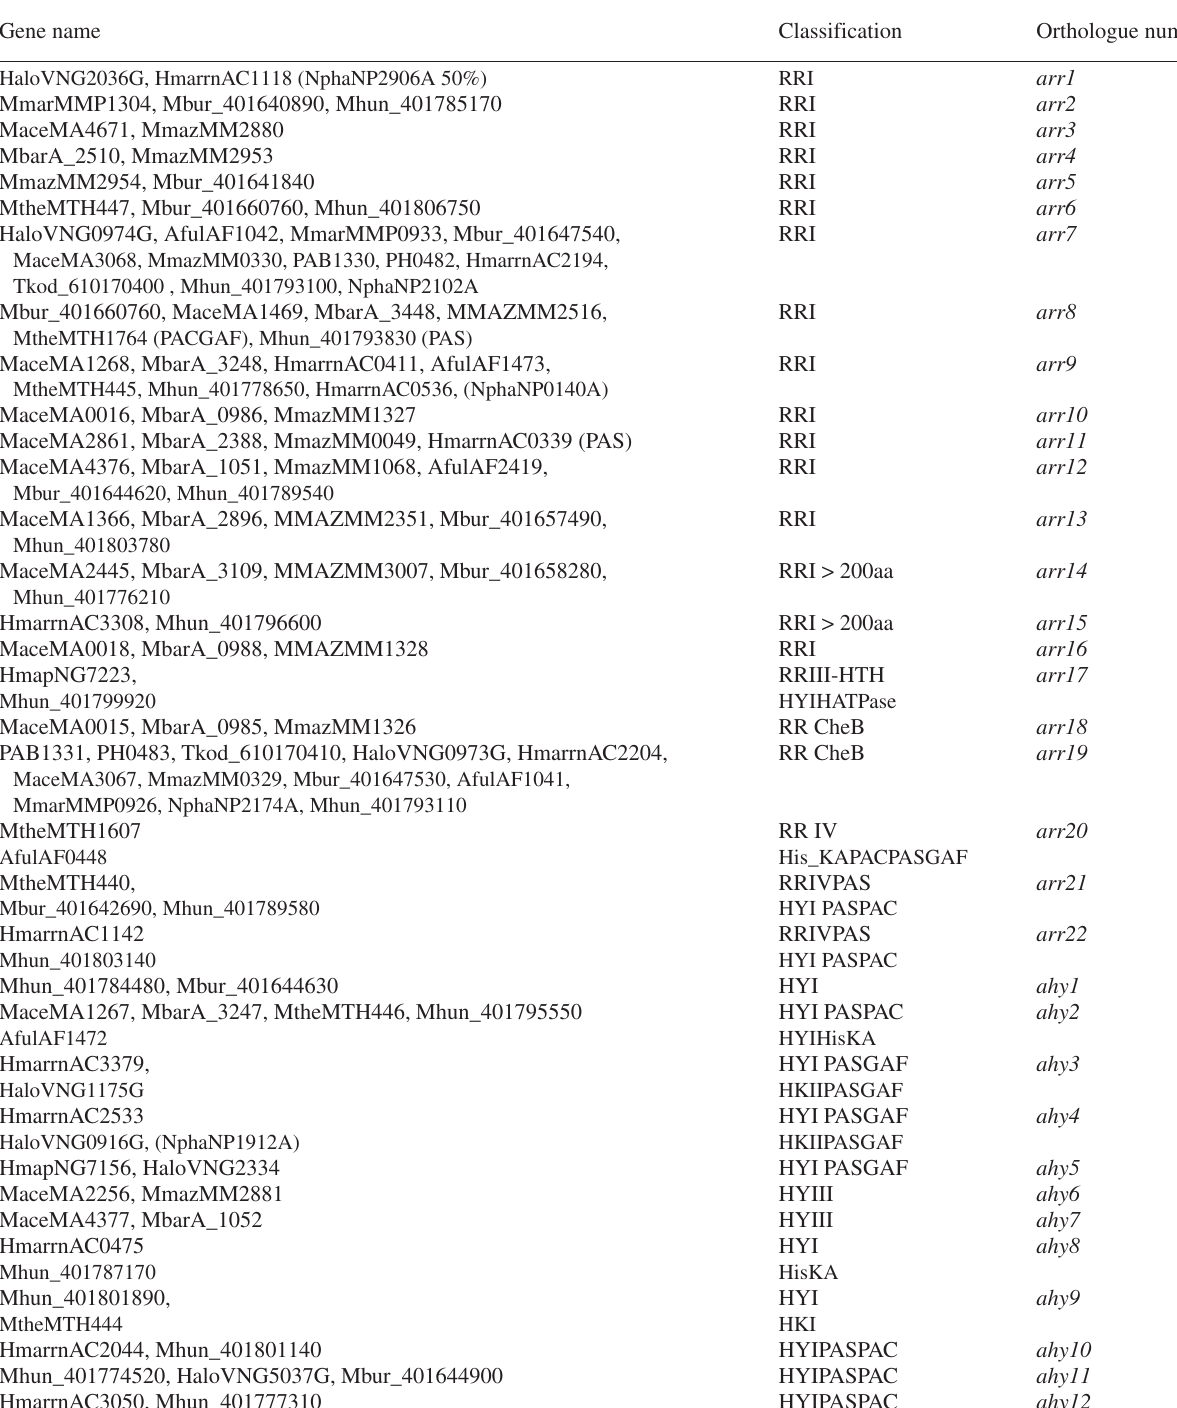
Table 4. Cont’d. Potential orthologous two-component open reading